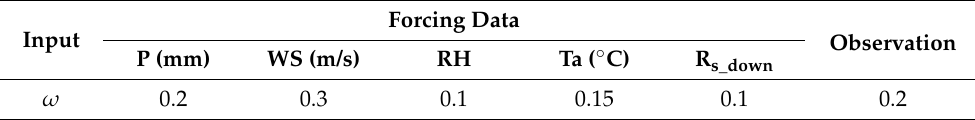
Table 4. Random distribution of forcing and observation data of data assimilation